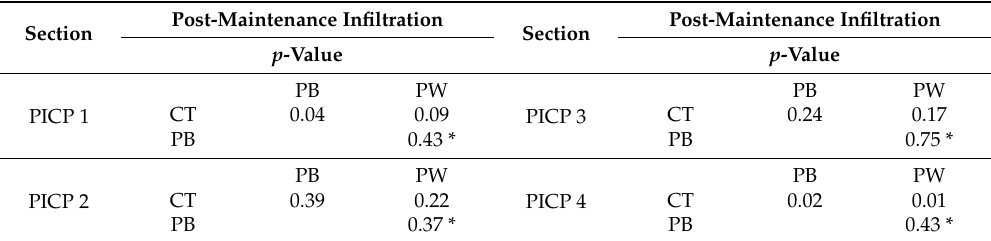
Table 10. Inter group significance of difference (GW test) between surface treatment spots.